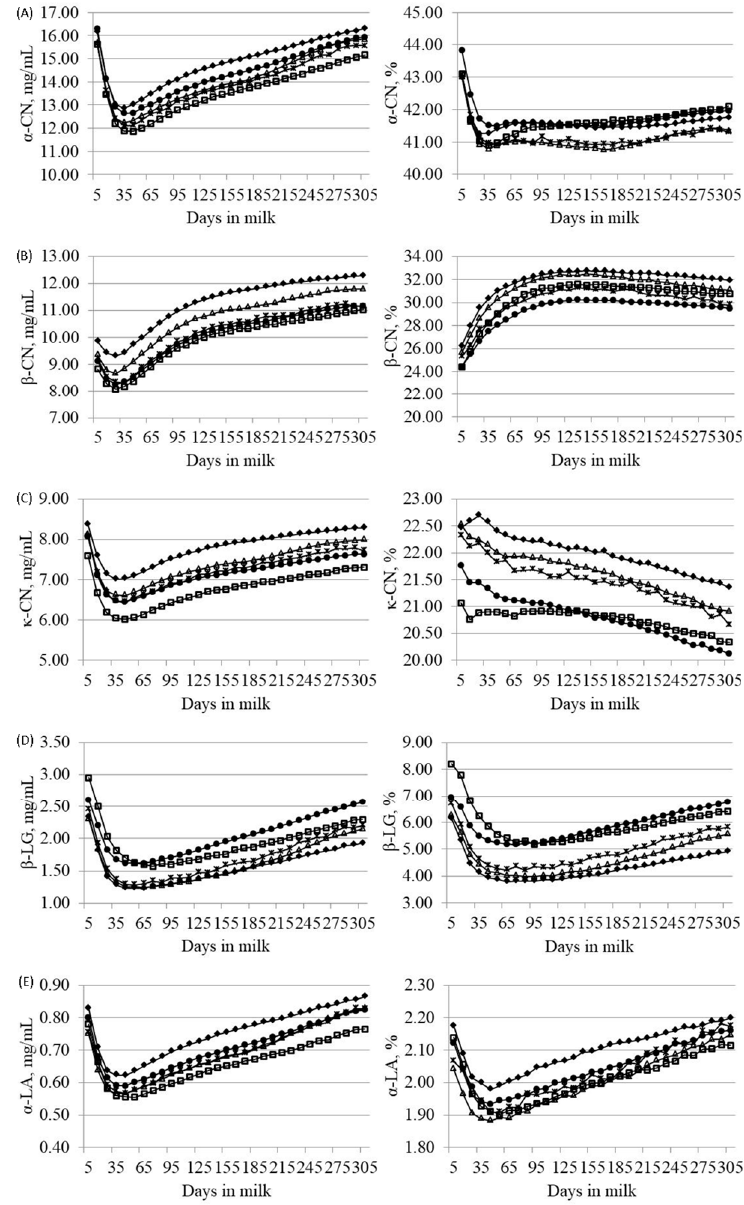
Figure 2. Least squares means of ( A ) α -casein ( α -CN), ( B ) β -casein ( β -CN), ( C ) κ -casein ( κ -CN), ( D ) β -lactoglobulin ( β -LG) and ( E ) α -lactalbumin ( α -LA) across lactation for Brown Swiss (- ♦ -), Holstein-Friesian (- □ -), Alpine Grey (- △ -), Simmental (- ● -) and Pinzgauer (-×-) cows, expressed as mg/mL of milk (on the left side) or percentage of crude protein (on the right side).